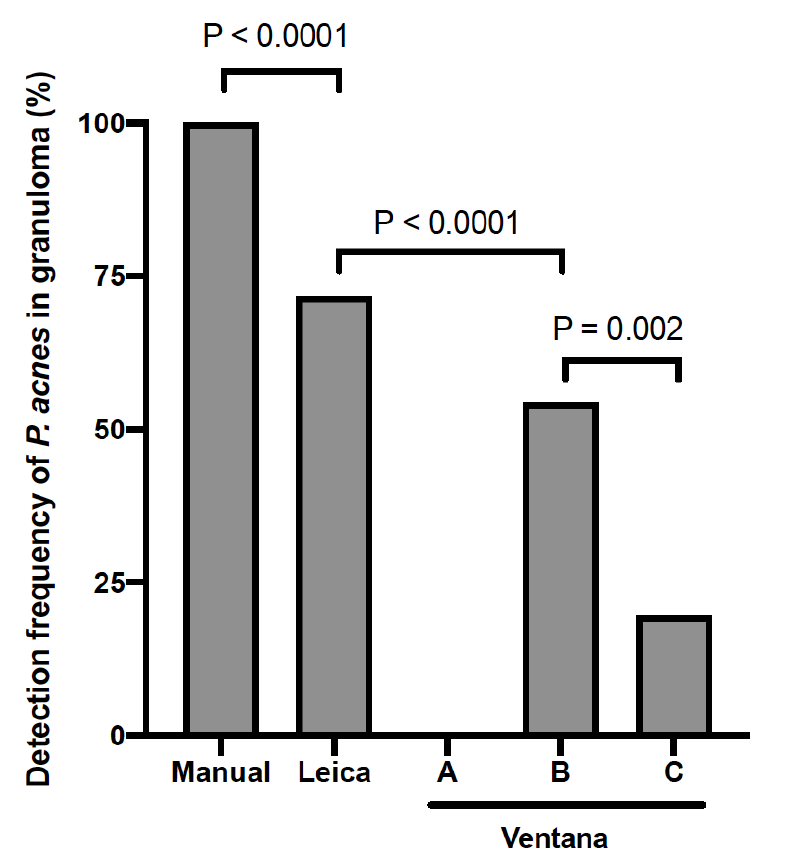
Figure 4. Detection frequency of P. acnes in sarcoid granulomas by immunohistochemistry using the Leica and Ventana systems. A total of 46 sarcoid tissue samples with P. acnes detected in granulomas by the manual method were used for comparison. Manual: a standard manual method according to the original protocol. Leica: a standard method using Leica Bond-III, Ventana A: a